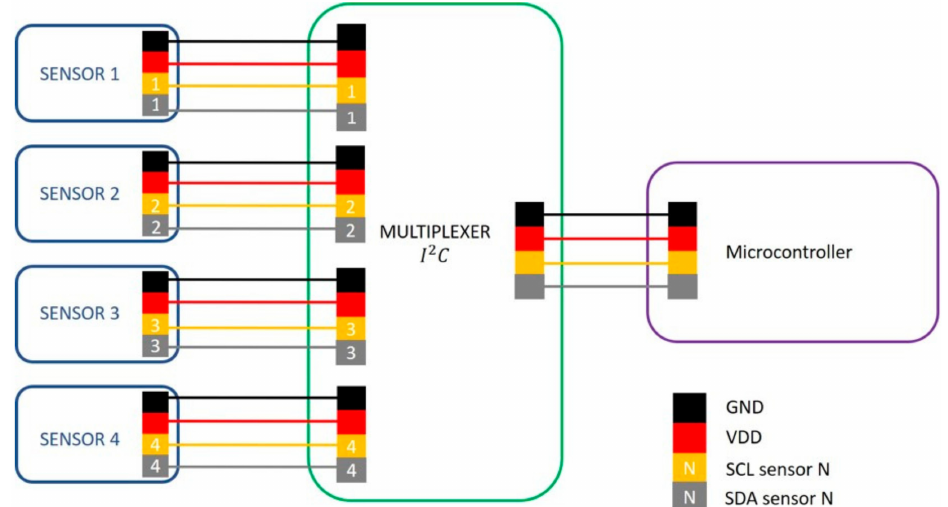
Figure 6. Communication architecture to manage data from optical proximity sensors. Because VCNL4040 sensors are provided with only one I 2 C address, an I 2 C multiplexer was added to allow the contemporary use of more than one sensor on the same